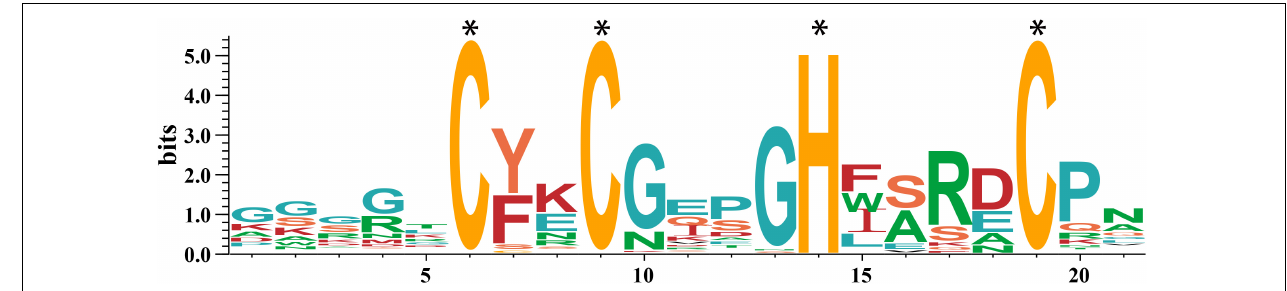
FIGURE 1 | Sequence of the CCHC motifs in wheat. The height of the letter at each location (in bits) represents the conservation of the sequences, and the height of every single letter means the relative frequency of the corresponding amino acid of that position. The * represents the completely conserved residues.